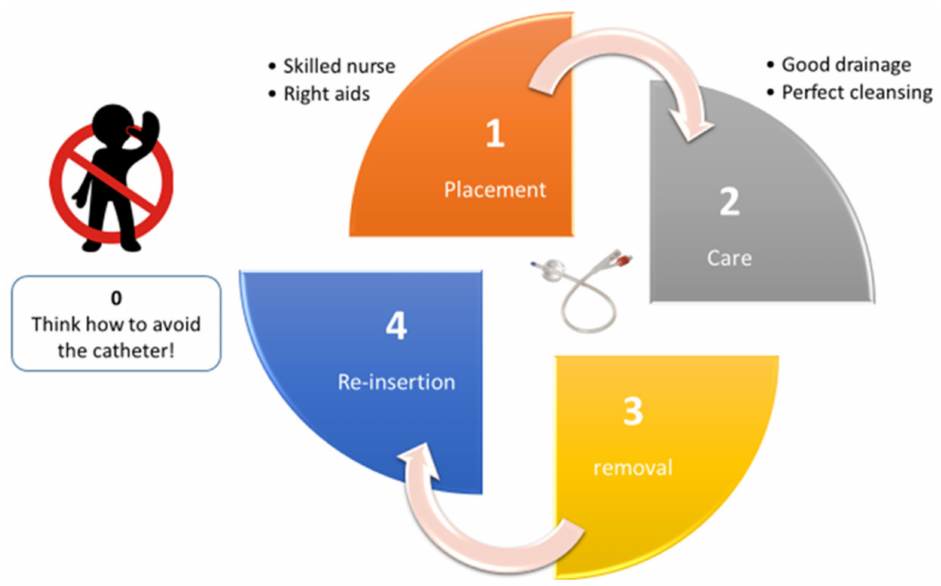
Figure 2. Catheter’s lifecycle : (1) consider when and why catheter placement is necessary; (2) daily management and care when catheter is inserted; (3) before catheter reinsertion, consider whether it may be definitively removed; (4) reduce the need for long-term indwelling catheter